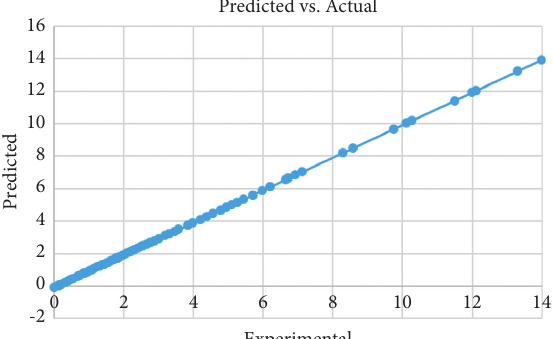
Figure 14: Correlation graph for Scheme C